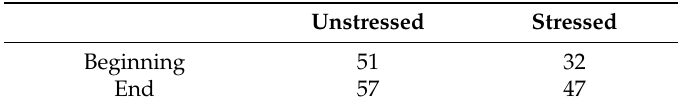
Table A2. Token counts for vowel formant measurements used to visualize vowel space and calculate vowel space area for Informant A in Section 4.2.1.